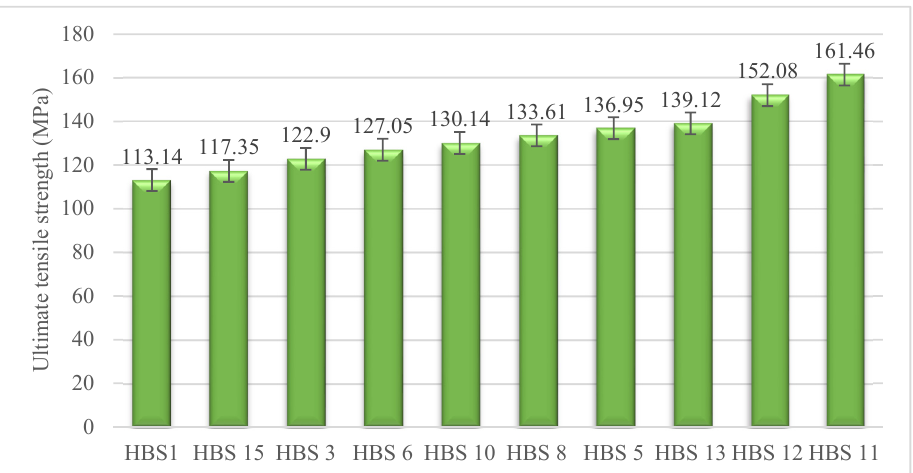
Figure 6. Average ultimate tensile strength of HBSs.